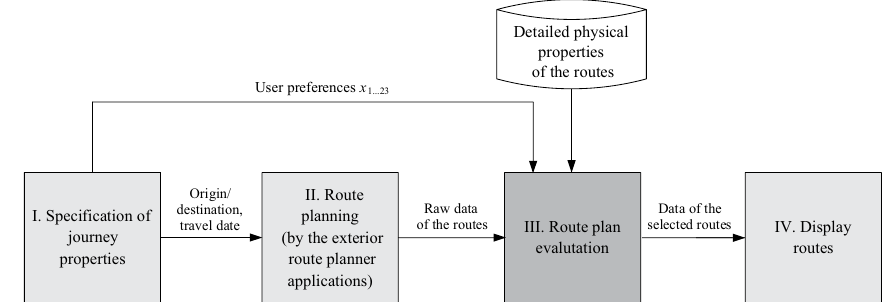
Fig. 4. Simplified operational flowchart of algorithm (source: research by the